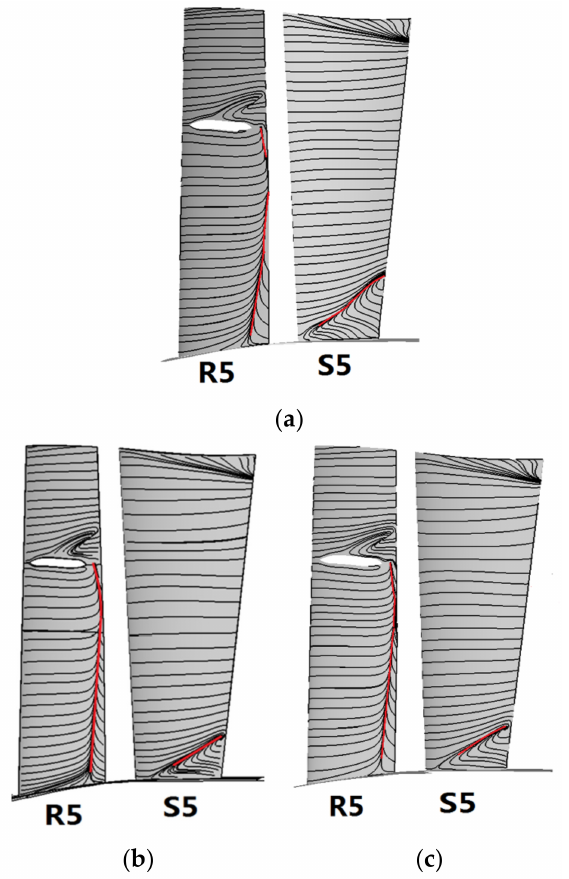
Figure 14. Limit streamline distribution of blade suction surface of fifth stage under peak efficiency conditions. ( a ) ABP, ( b ) R5RI, ( c )